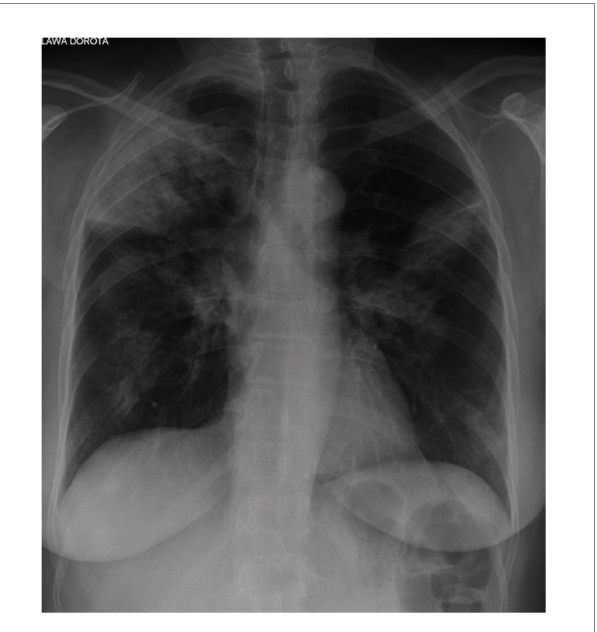
FIGURE 1 Chest X-ray of OP. Bilateral opacities localized in the peripheral parts of the both lungs.